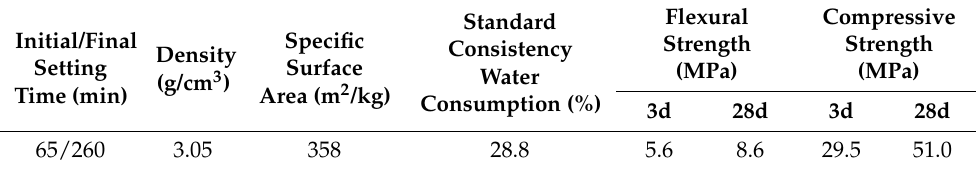
Table 1. Physical and mechanical properties of